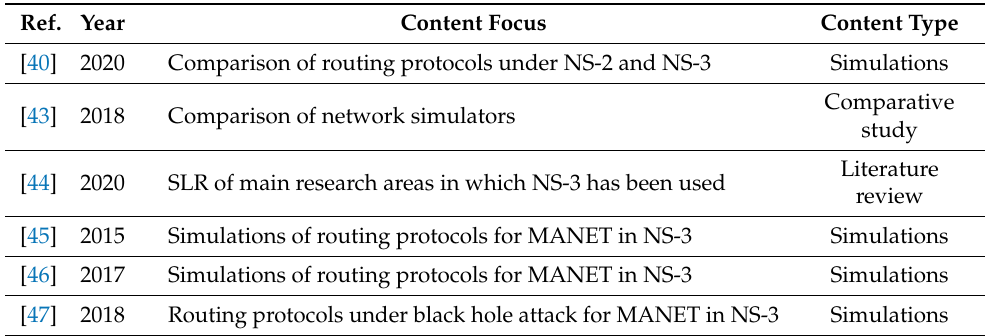
Table 1. Papers dealing with the use of network simulators in general.